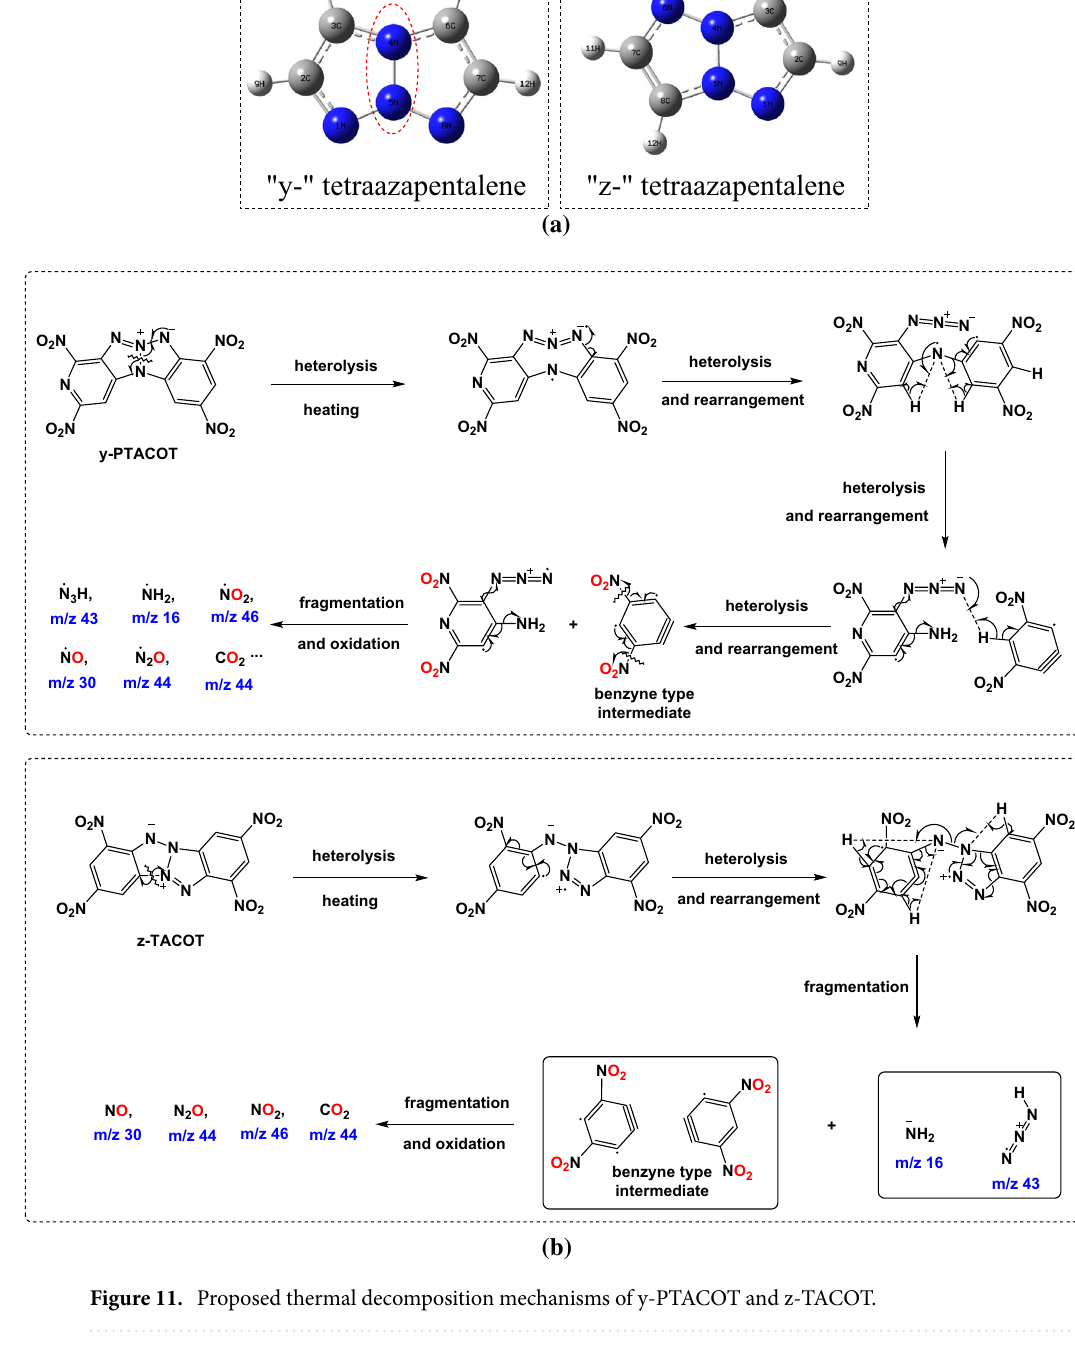
Figure 11. Proposed thermal decomposition mechanisms of y-PTACOT and